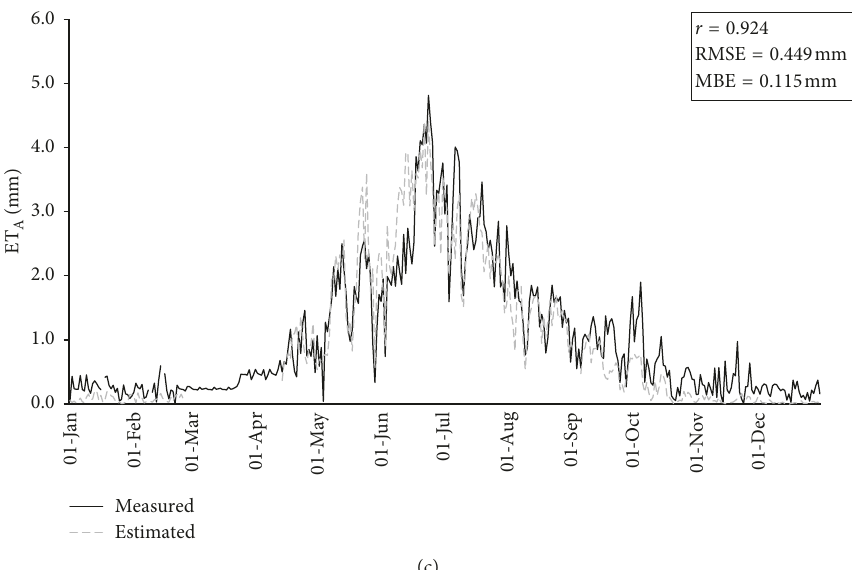
Figure 5: Annual evolutions of daily precipitation (PREC) and potential evapotranspiration (ET (b), and measured and estimated ET A (c) for Collelongo (all correlations are highly significant, P < 0 .